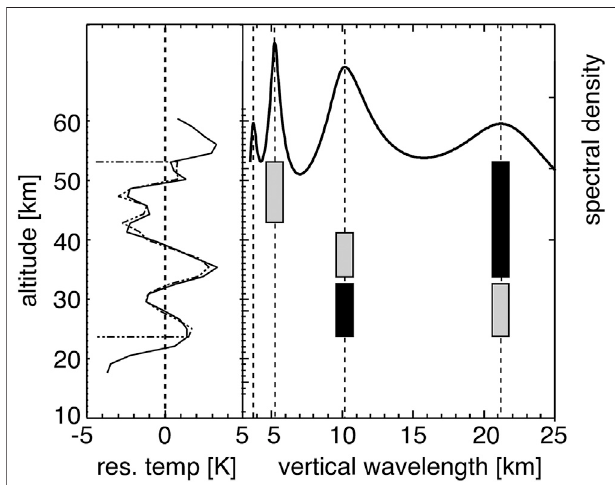
FIGURE 2 | An example of MEM/HA technique applied on temperature pro fi le observed by CRISTA 1 over Chili at 24 0 S and 82 0 W. Left panel is showing altitude pro fi le Kalman detrended temperature residual (solid) and reconstructed fi t(dash). Rightpanel is showing MEM spectrum,spectral peaks (bottom to top vertical lines) and two leading amplitudes (solid and hatched bars). Adapted from Figure 10: Preusse et al.